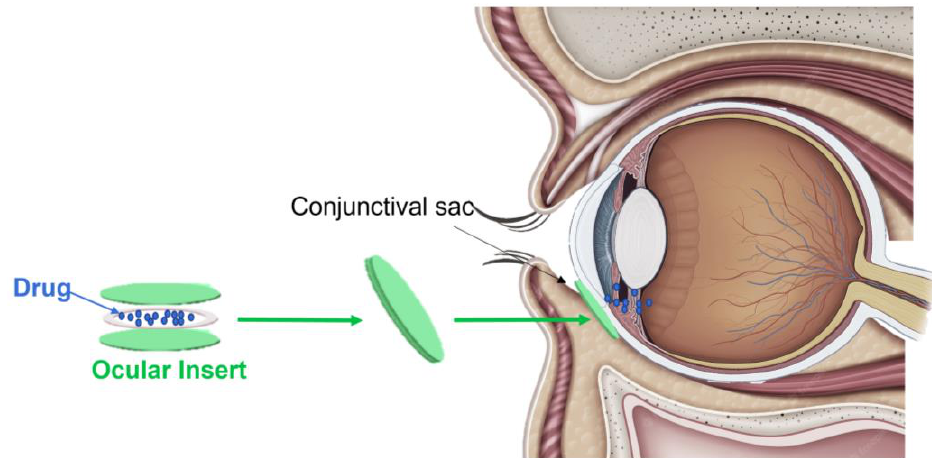
Figure 2. Representative image of a drug-loaded ocular insert (OI). A drug-loaded OI is a thin synthetic device composed of polymeric multilayers loaded with desired drugs. It is directly inserted into the conjunctival sac, successively releasing in a sustained manner the active compound in the anterior segment of the eye via diffusion, osmosis, or bioerosion mechanisms based on its physical properties.